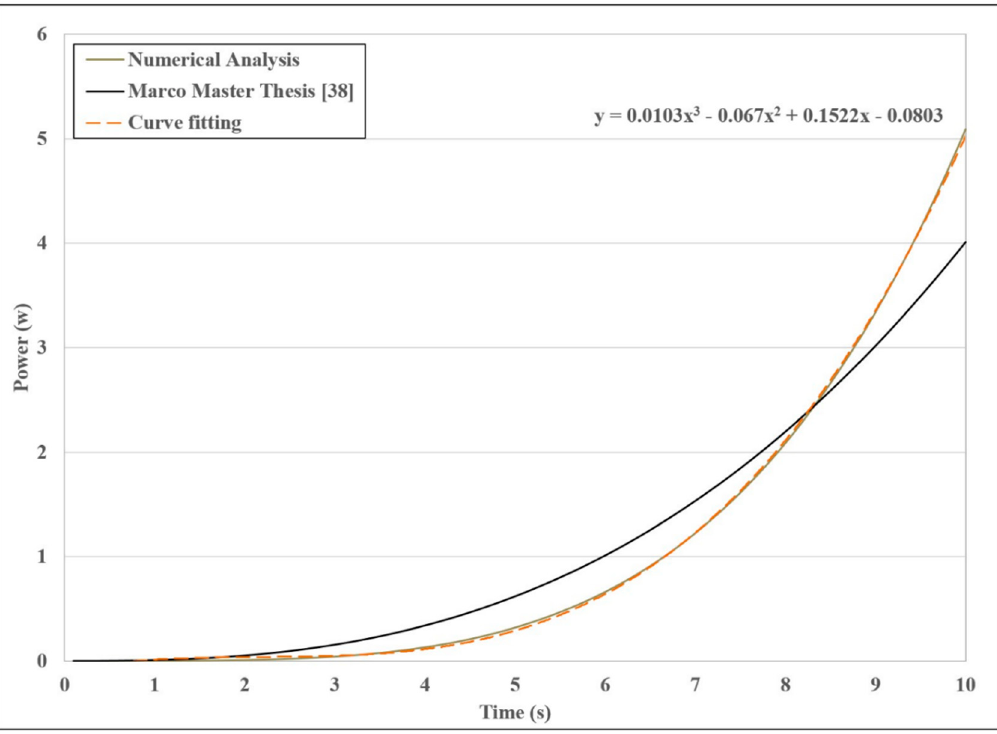
Figure 9. The effect of increasing the wind flow velocity on produced power.